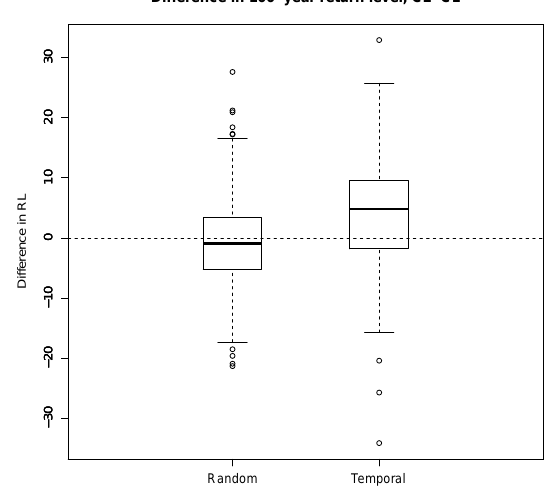
Figure 11. Box plot of the difference in 100-year return level esti- mated for C ( 1 ) and C ( 2 ) with MEWP ( 0 . 5 , 2 , 8 ) under random sam- pling (left) and temporal sampling (right) (one point per